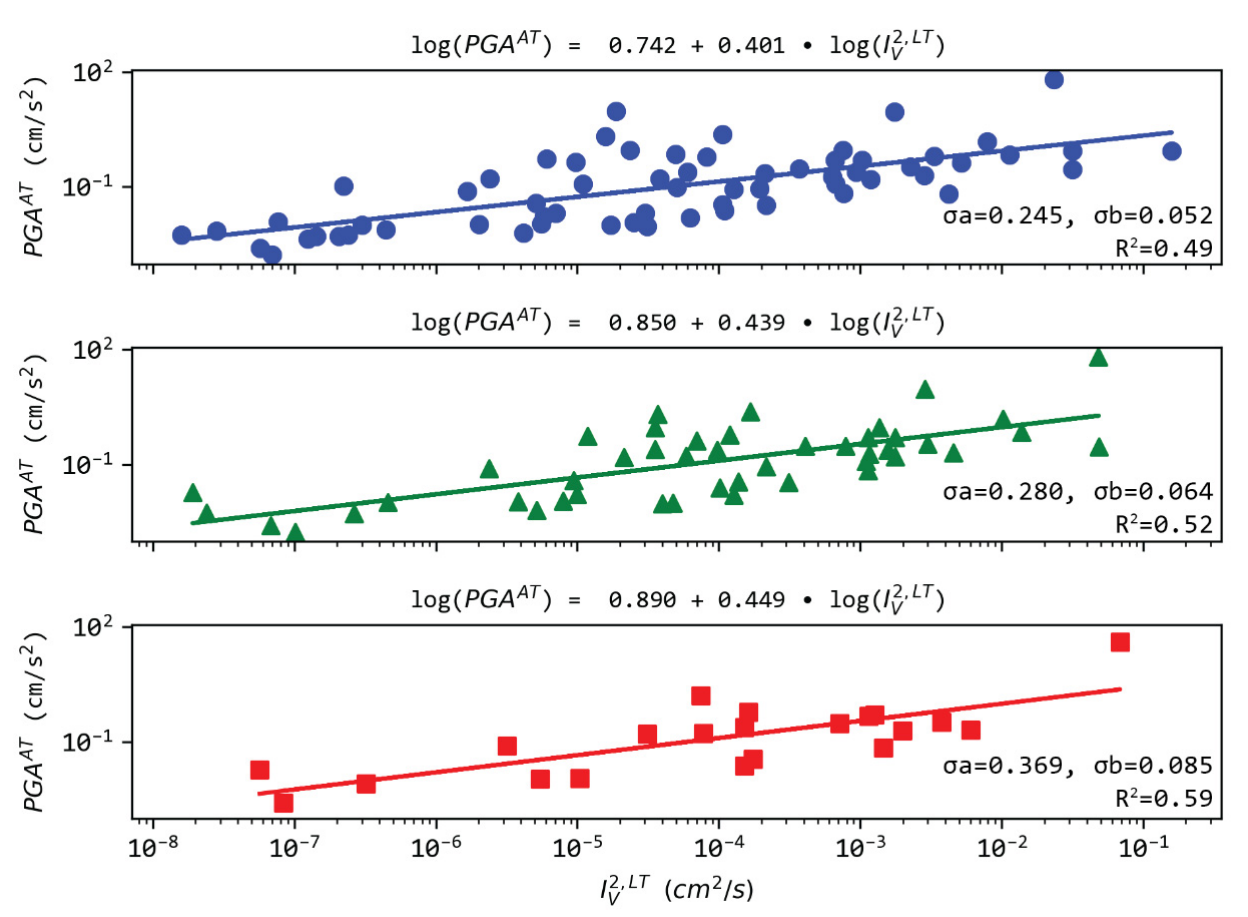
Figure 11. Regression analysis between PGA measured in Athens (AT) and I 2 in Loutraki (LT). The rest of the notation as in Figure 3.